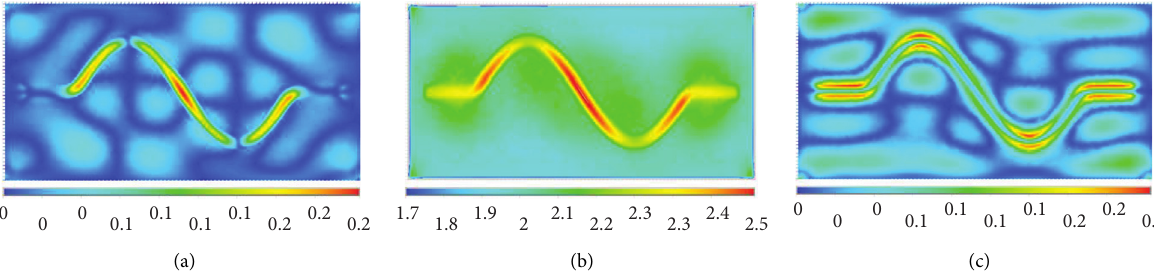
Figure 14: SH wave incident ( f � 1.0Hz, H � 100m, C